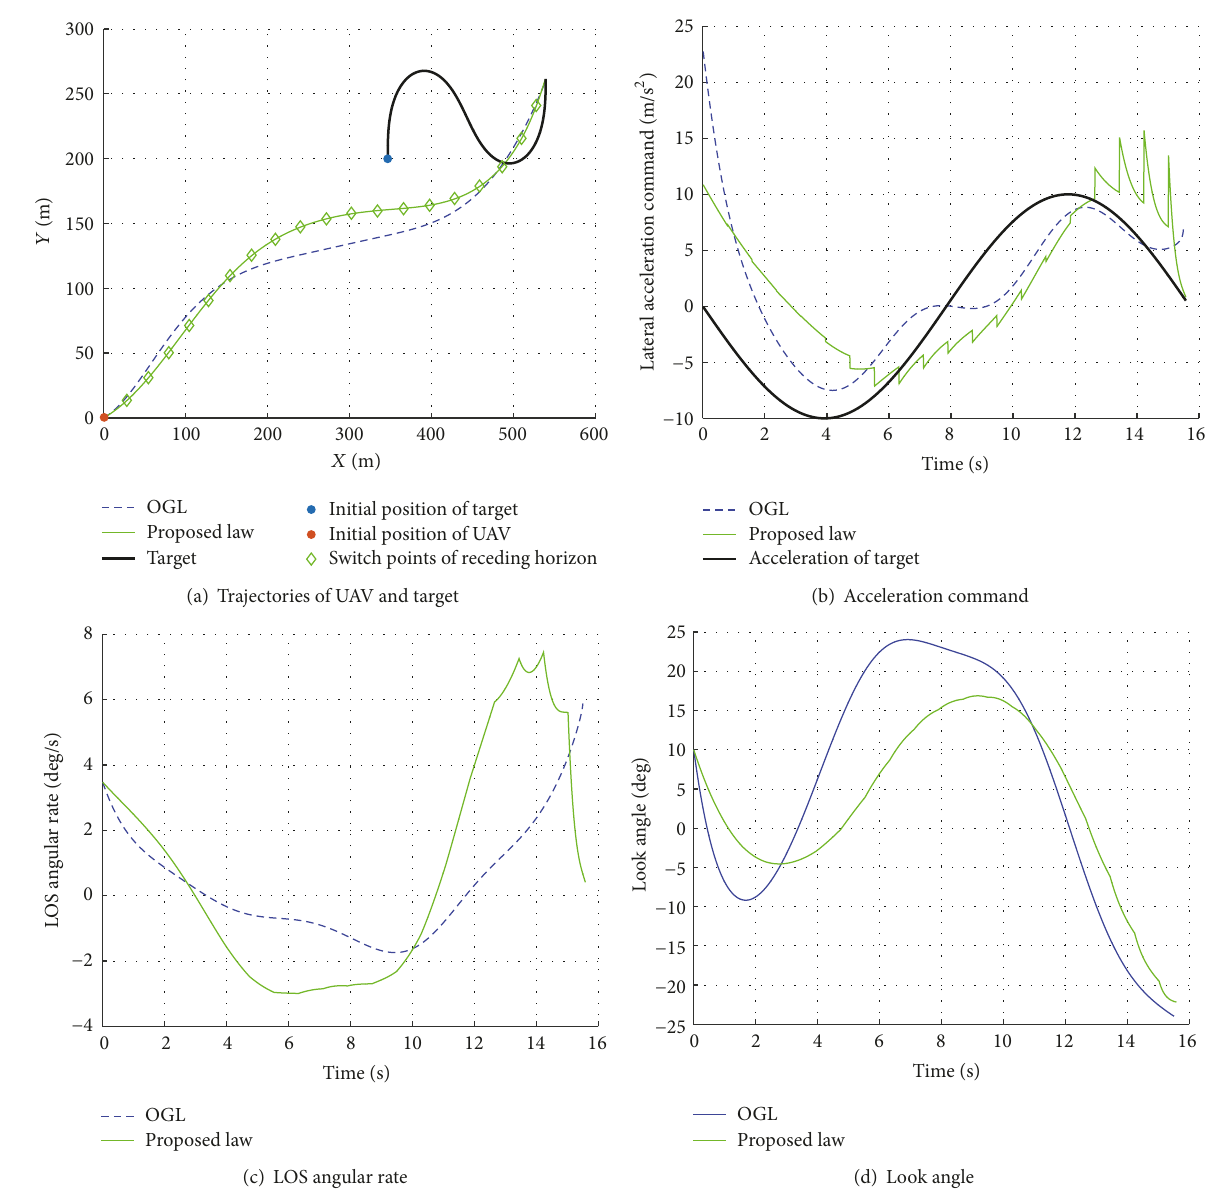
Figure 15: Responses in Case 2 (𝑎 𝑇 = −10 sin (0.4𝑡))